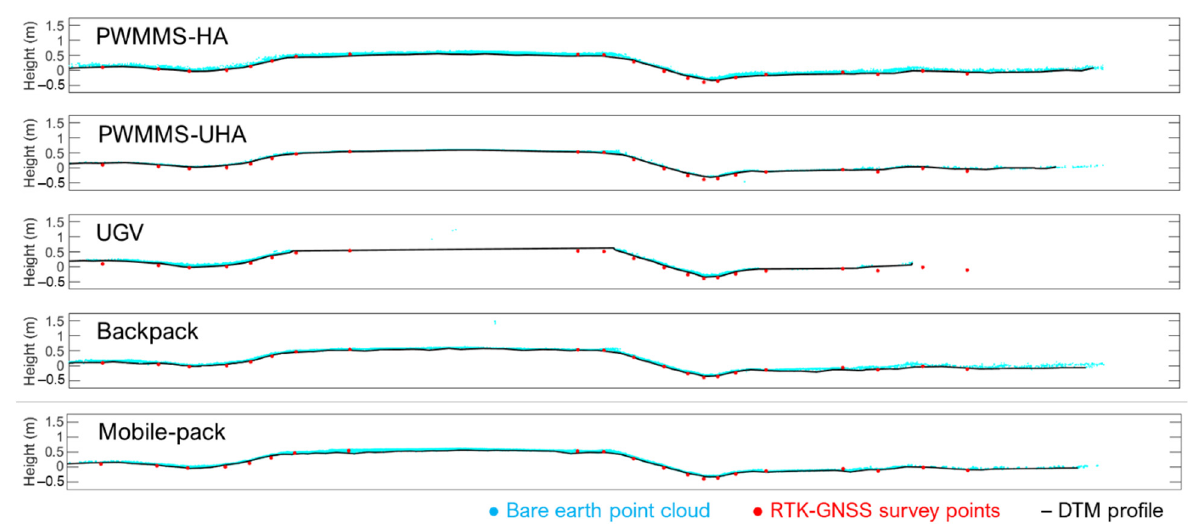
Figure 15. Cross-sectional profile at location PB3 showing the point cloud, DTM, and real-time kinematic global navigation satellite systems (RTK-GNSS) survey points.